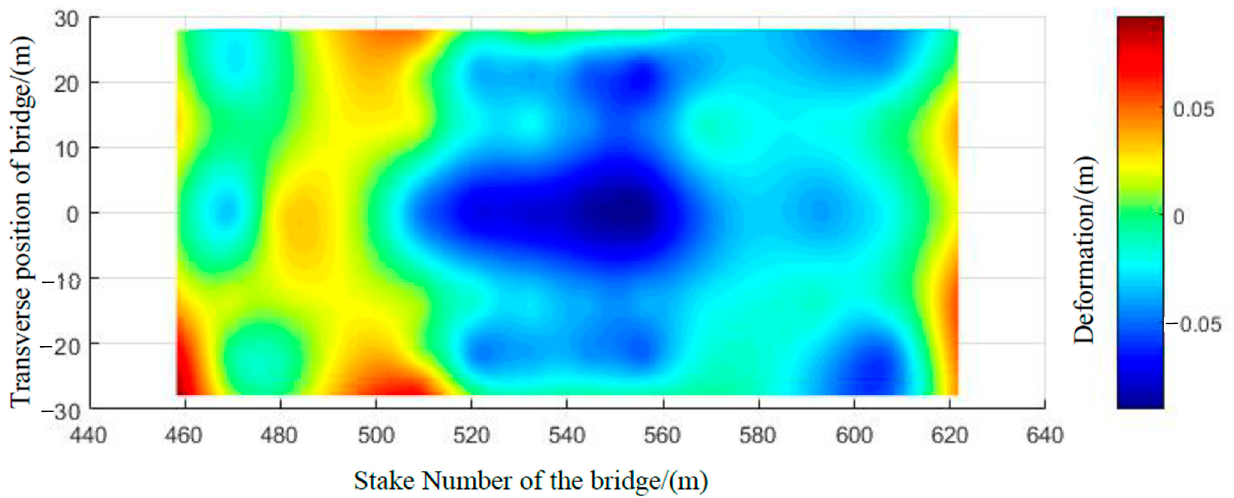
Figure 15. Top view of the distribution of the abnormal deformation.